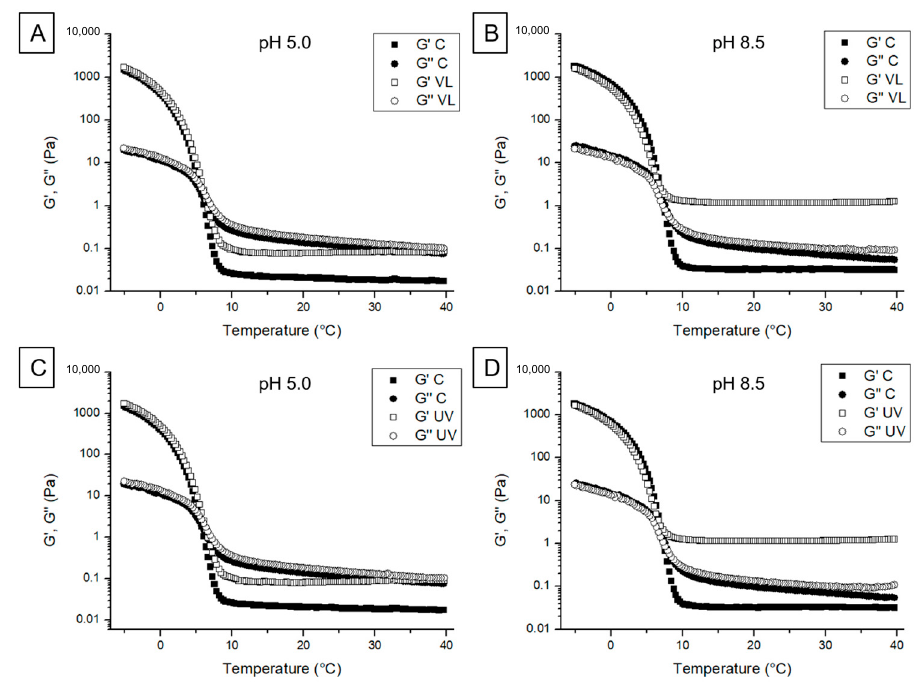
Figure 2. Storage modulus ( G ’) and the loss modulus ( G ”) of gelatin–riboflavin suspensions on cooling. Visible light (VL): ( A ) and ( B ); ultraviolet light (UV): ( C ) and ( D ). Control (C): no light exposure.